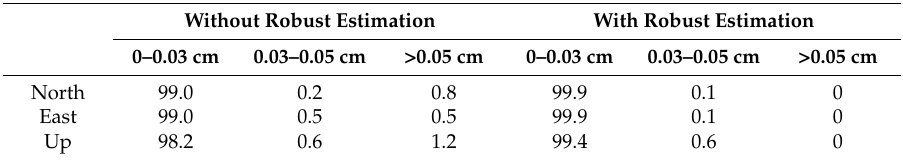
Table 2. Ambiguity-Fix Rate ( AFR) of S1 and S3.